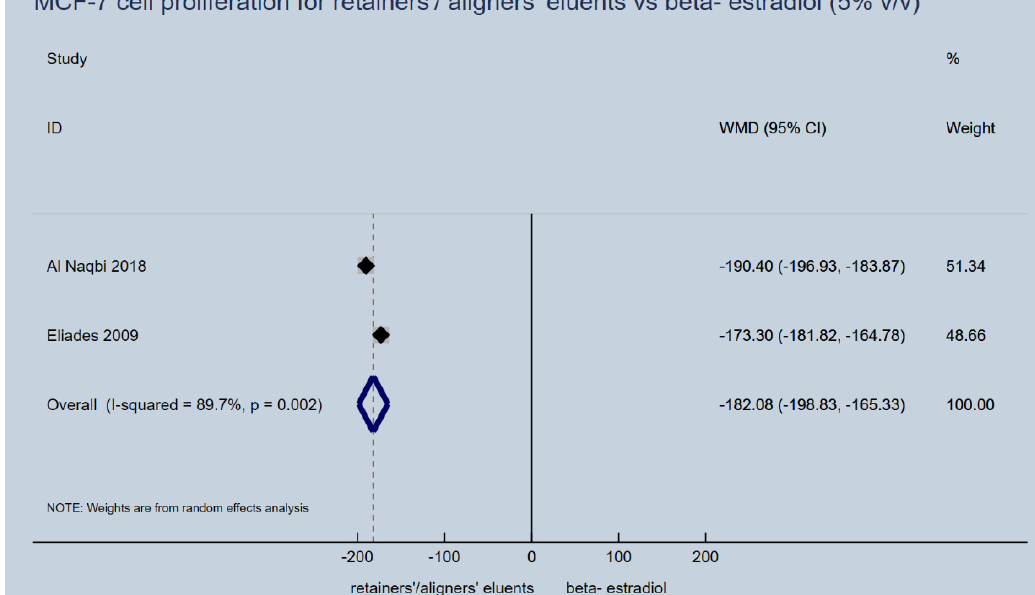
Figure 4. Random effects meta-analysis on the effect of thermoplastic appliances’ eluents versus beta- estradiol (20% v/v) to induce proliferation activity of MCF-7 cells. Similarly, the results of a single study [5] that used BPA as an active control compared to aligners’ eluents MCF-7 cell proliferation dynamics, were in the same line as with beta-estradiol described above (5% v/v, MD: − 74.1; 95% CI: − 78.8, − 69.4; p -value < 0.001 and 20% v/v, MD: − 73.9; 95% CI: − 78.7, − 69.1; p -value < 0.001) (Table 3). Cytotoxic activity based on the potential for proliferation of human gingival fibroblasts, as reported in the same single study, was also not detected for aligners’ eluents and appeared even lower that the control normal saline. The single studies of Kotyk 2014 [28] and Schuster 2004 [29], did not report any measurable traces of either BPA or residual monomers and oxidative byproducts for any thermoplastic aligner/retainer under study.